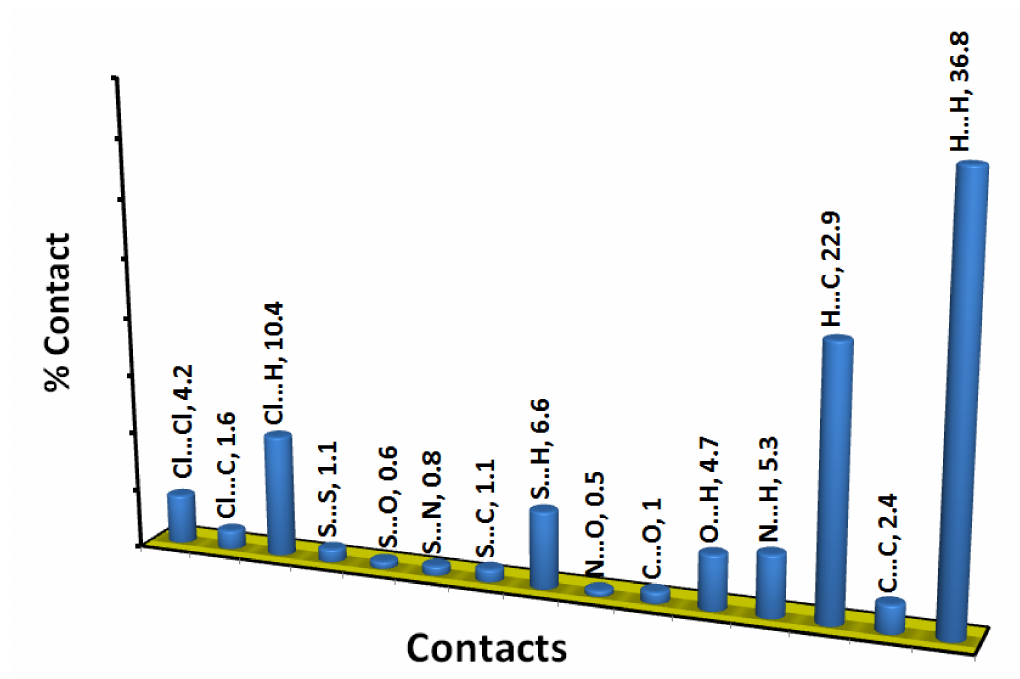
Figure 5. Intermolecular interactions in 4 .